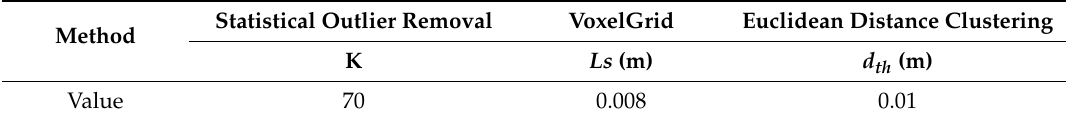
Table 2. The key parameters in the preprocessing